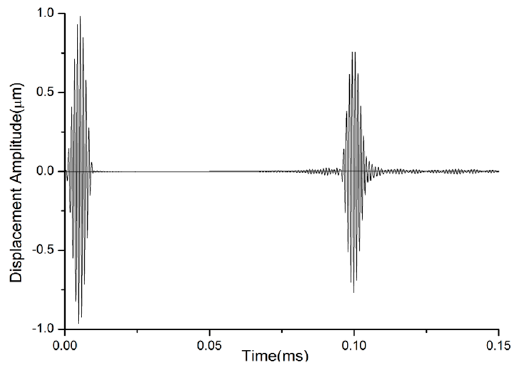
Figure 3. Simulated waveforms in a waveguide bar (thickness 1 mm and width 15 mm).